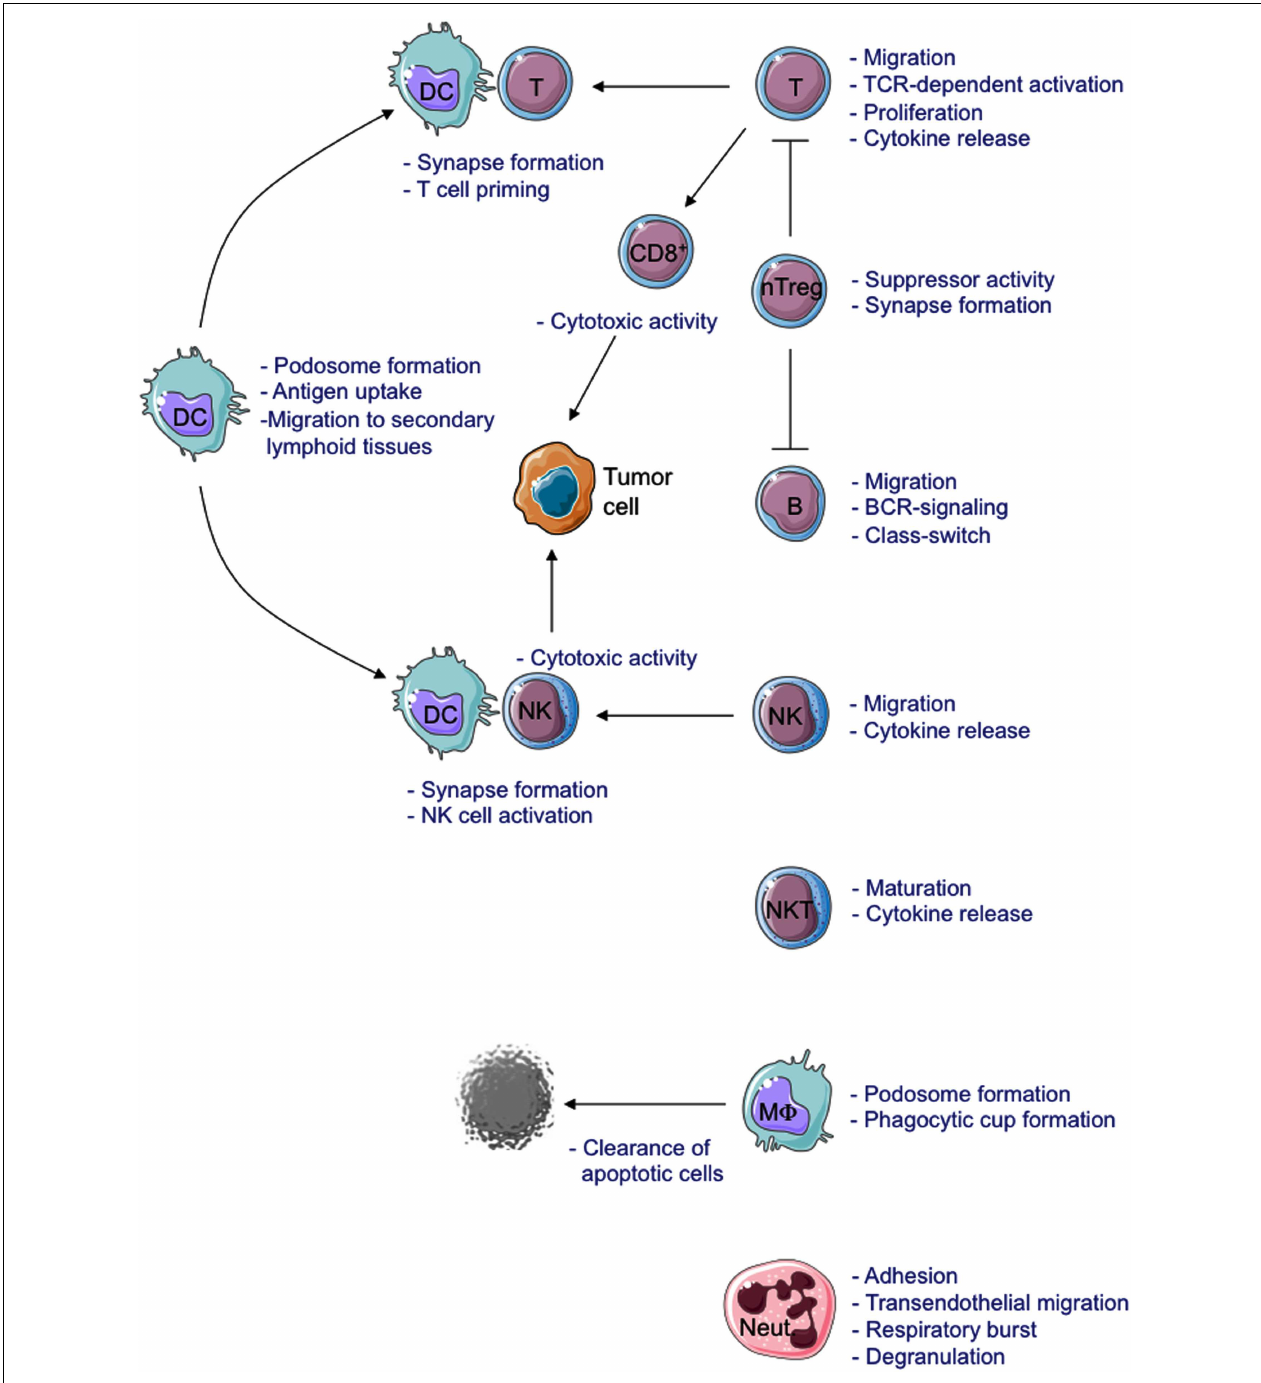
FIGURE 2 | Schematic view of cellular defects described inWASP-deficient cells. M Φ , Macrophage; Neut., Neutrophil.